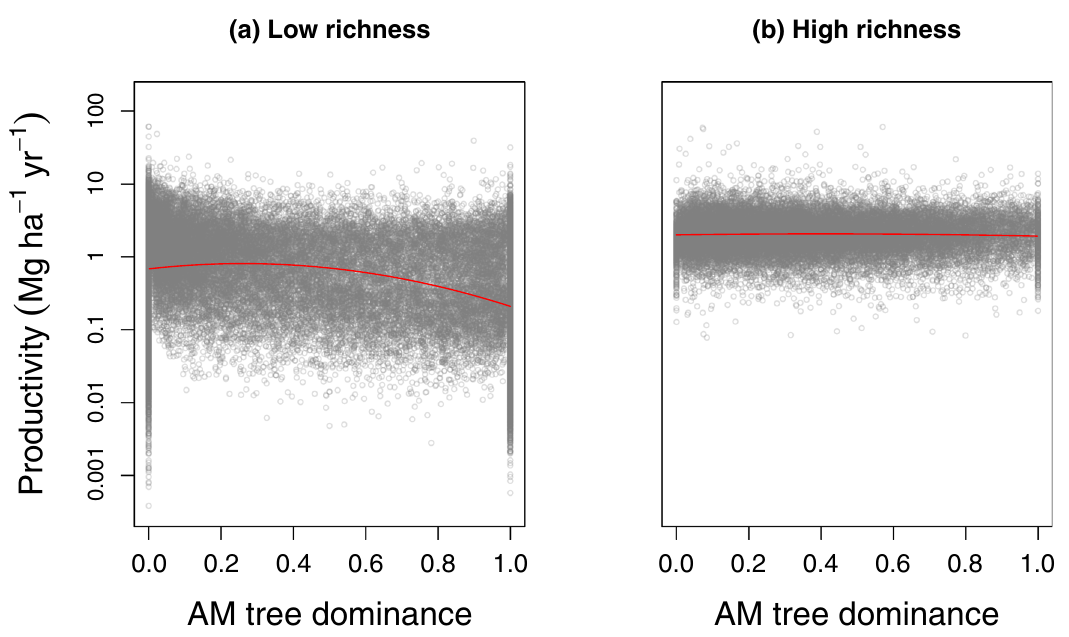
Fig. 4 | Relationships between AM tree dominance and productivity in forests with low vs. high species richness. a Forests with low tree species richness (richness ≤ 5). b Forests with high tree species richness (richness > 5). We fi tted general linearmodels with ecoregion, AMproportion (linearand quadratic terms),